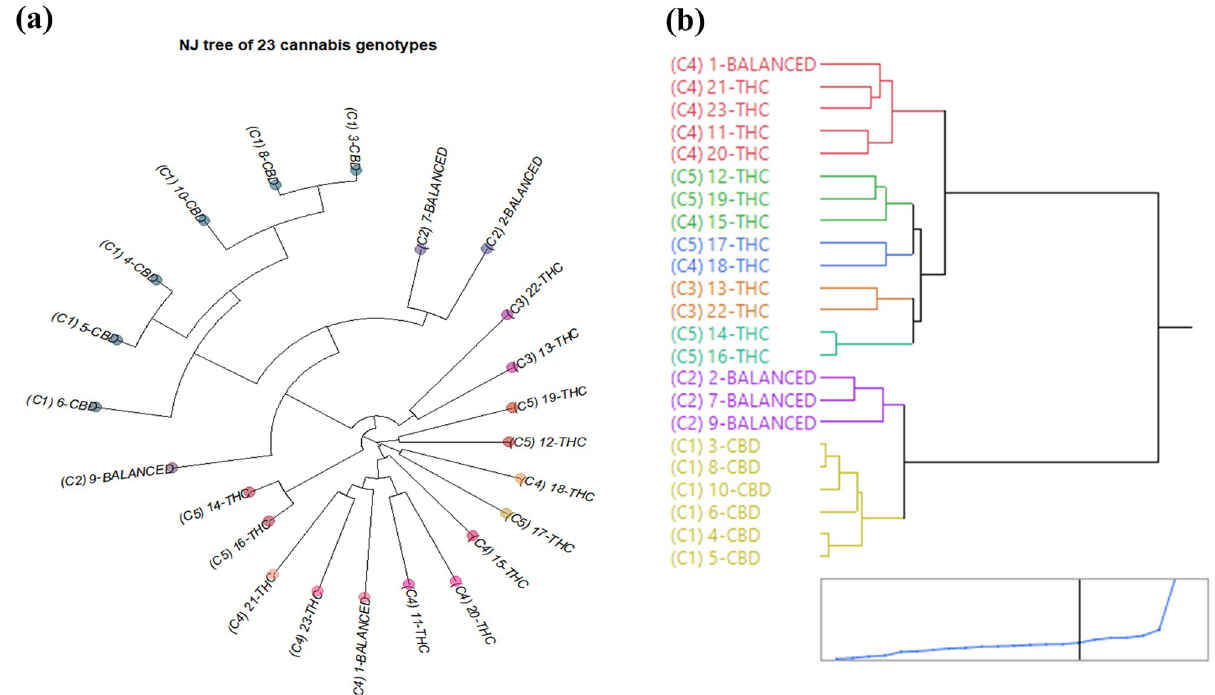
Fig 4. NJ-tree and hierarchical clustering using the 344 multiallelic SNPs (a) NJ-tree and (b) The dendrogram using hierarchical clustering by Ward’s method for 23 cannabis genotypes. Clusters indicated as C1, C2, C3, C4, and C5 corresponds to I-SNPs in Table 1.